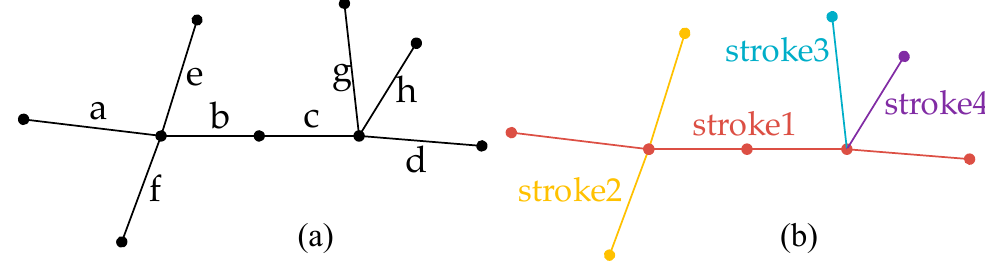
Figure 1. ( a ) Segments of pipelines; ( b ) strokes of pipelines.